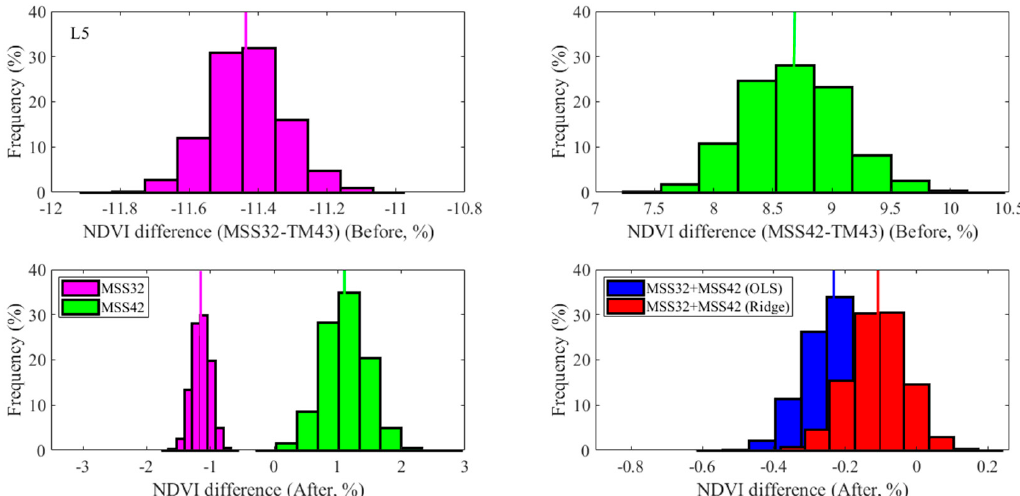
Figure 5. NDVI di ff erence (MdRD) between MSS and TM of Landsat 5 before (top row) and after (bottom row) transformation. The histograms are based on 10,000 times K-fold (K = 5) cross-validation tests, while the equally spaced steps for the histograms are 0.094%, 0.326%, 0.123%, 0.326%, 0.073%, and 0.069% respectively. The vertical lines show the median values of NDVI di ff erence correspondingly. The median MdRD with lower and upper bounds for cross-validation tests are − 11.44% ( − 11.65%, − 11.23%) and 8.68% (7.90%, 9.50%) before transformation (top row), while − 1.15% ( − 1.43%, − 0.88%), 1.11% (0.42%, 1.78%), − 0.23% ( − 0.40%, − 0.07%), and − 0.11% ( − 0.28%, 0.04%) after transformation through respective models (bottom row).